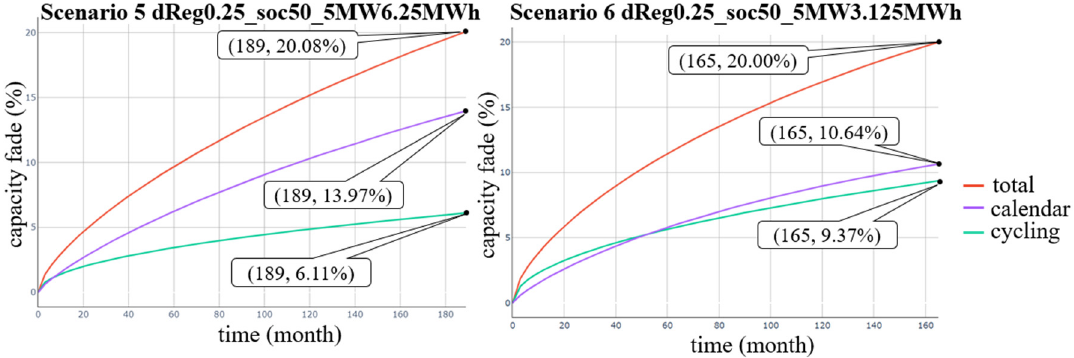
Figure 15. The result under different C-rates using dReg0.5 and dReg0.25.